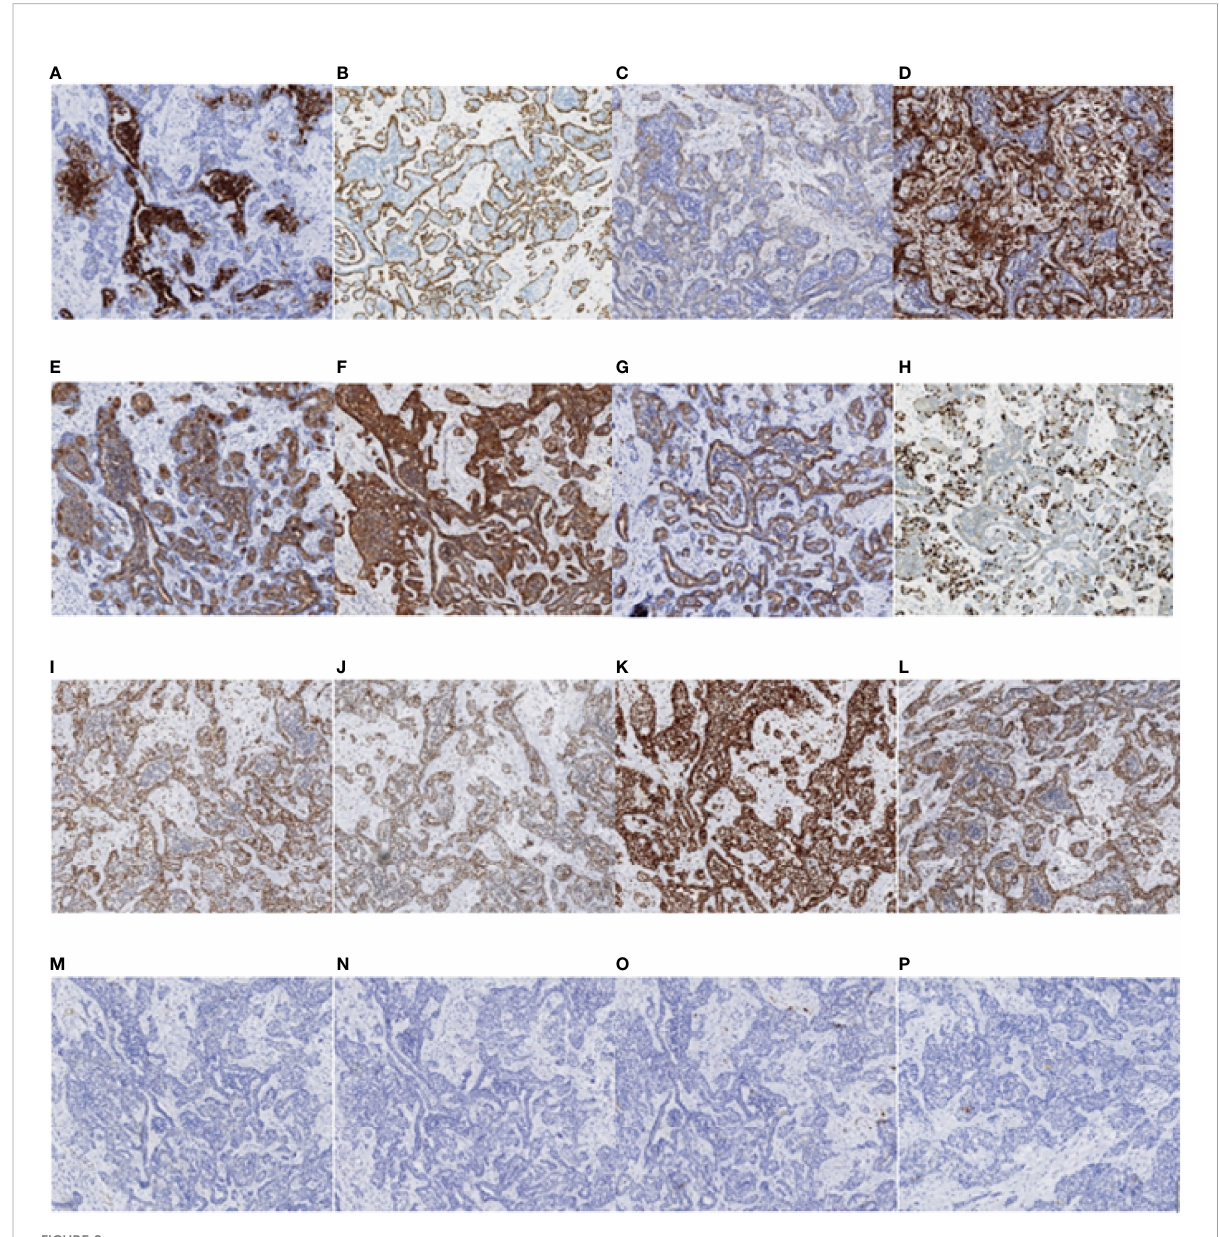
FIGURE 8 Immunohistochemistry test results of the nasopharyngeal biopsy obtained on 17 April 2019. (A) CK7 positivity was observed in epithelial cells. (B – D) P63, SMA, and VIM positivity was observed in myoepithelial cells. (E – G) CK, EGFR, and CD117 positivity was observed in tumor cells. (H) Ki-67 positivity was observed in 35% of the tumor cells. (I – L) MLH1, MSH2, MSH6, and PMS2 positivity was observed in tumor cells. (M – O) Actin, GFAP, and S-100 negativity was observed in tumor cells. (P) PD-L1 positivity was observed in less than 1% of tumor cells and in 10% of stromal cells (magni fi cation, ×10). CK, cytokeratin; SMA, smooth muscle actin; VIM, vimentin; EGFR, epidermal growth factor receptor; GFAP, glial fi brillary acidic protein; PD-L1, programmed death